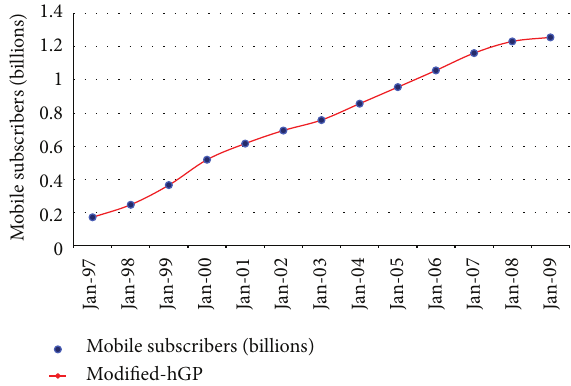
Figure 11: The fitting performance of the modified-hGP model for the total number of OECD subscribers.